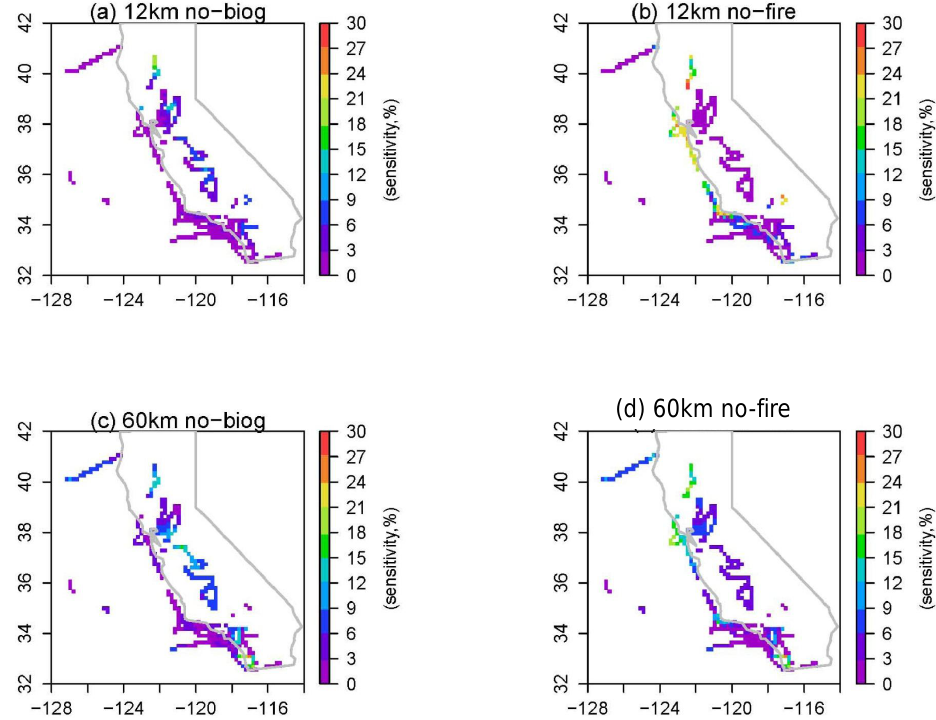
Figure 5 Model O 3 sensitivity for (a;c) no-biogenic case (b;d) no-fire case from the 12 km (a-b) and 60 km (c-d) cases. Fig. 5. Model O 3 sensitivity for (a, c) no-biogenic case (b, d) no-fire case from the 12km (a–b) and 60km (c–d)